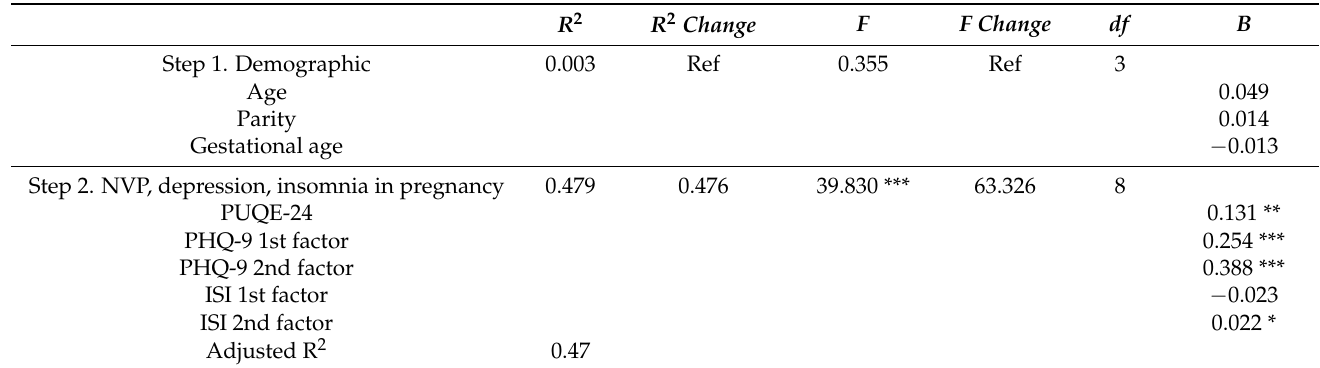
Table 5. Hierarchical multiple regression analyses of SDS with PUQE-24 and PHQ-9 subscales and ISI subscales in